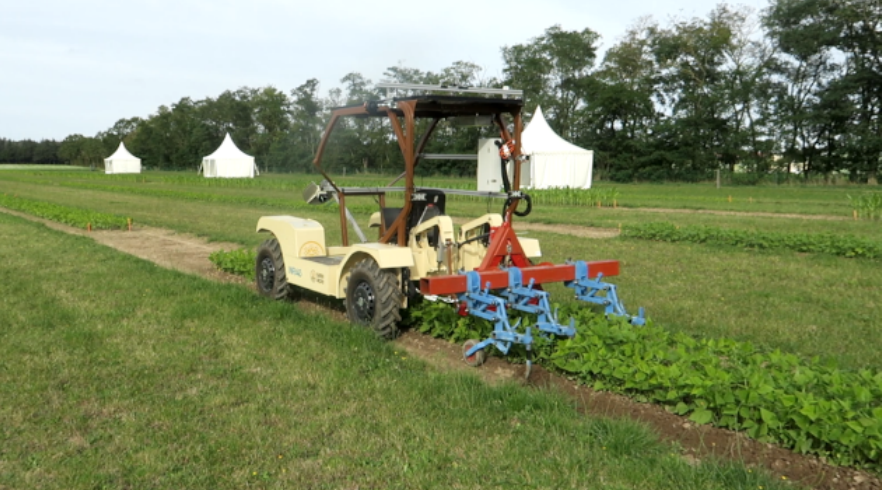
Figure 1. SabiAgri electrical and automatized tractor used for full-scale